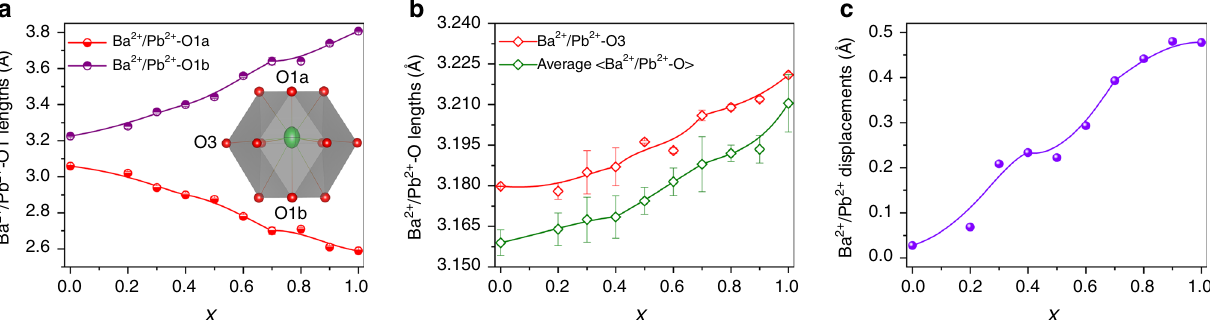
0.0 Fig. 5 Evolution of Ba/Pb − O bond lengths and Ba/Pb displacements. Plots of Pb 2 + /Ba 2 + − O1 bond lengths a , Pb 2 + /Ba 2 + − O3 and average < Pb 2 + /Ba 2 + − O > bond lengths b , and average Pb 2 + /Ba 2 + displacement distance c against the Pb content in CaBa 1 − x Pb x Zn 2 Ga 2 O 7 . The inset shows the coordination environment of Ba 2 + /Pb 2 + in CaBa 1 − x Pb x Zn 2 Ga 2 O 7 (0 < x < 1) obtained from Rietveld re fi nements against XRD data with the P 6 3 mc model, where a highly anisotropic thermal motion along c axis can be visually observed. For x = 0, 0.5, and 1, the parameters are obtained from combined Rietveld re fi nement against both XRD and ND data. Source data are provided as a Source Data fi le.